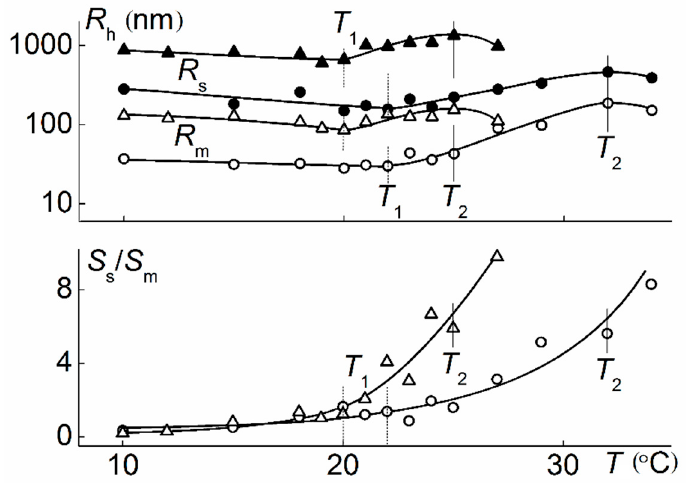
Figure 11. The temperature dependences of hydrodynamic radii R h and S s / S m for middle (open signs) and slow (filled signs) scattering species at c = 0.00020 g · cm − 3 (circles) and 0.0105 g · cm − 3 (triangles) in APE-g-PiPrOx aqueous solutions.